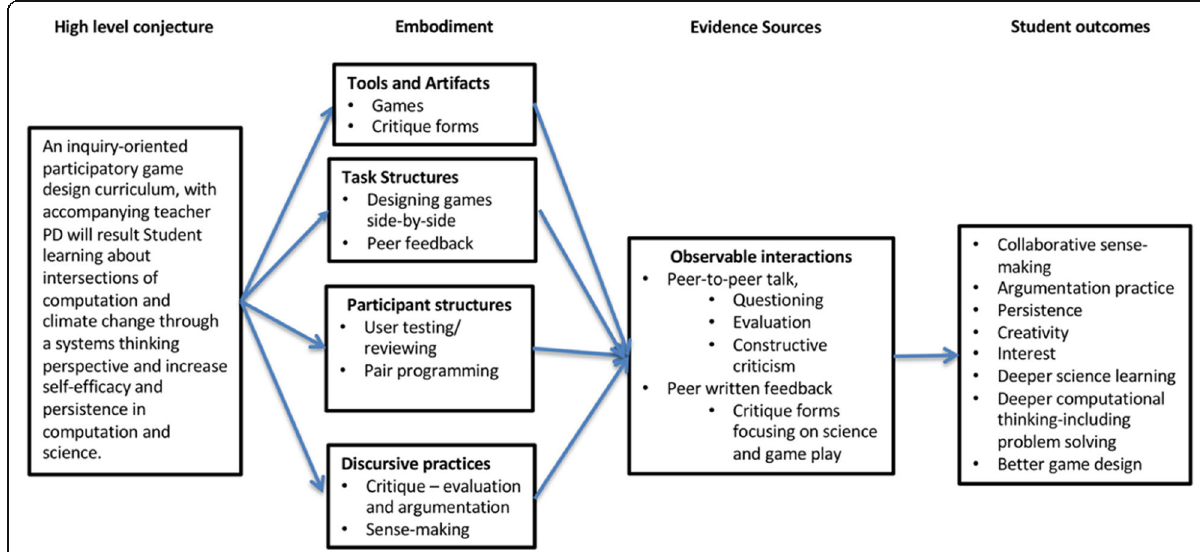
Fig. 1 Design conjectures about the role of